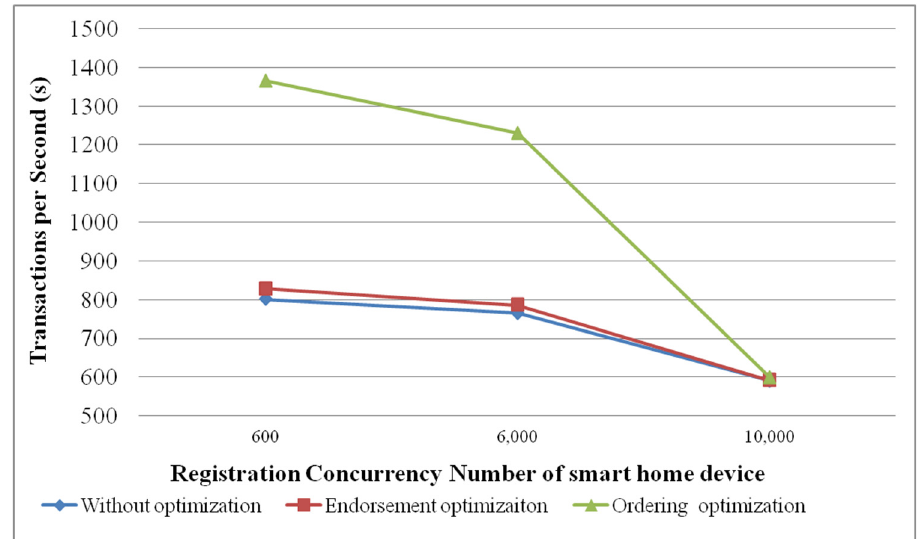
Figure 13. The performance results of smart home device registration based on Fabric.